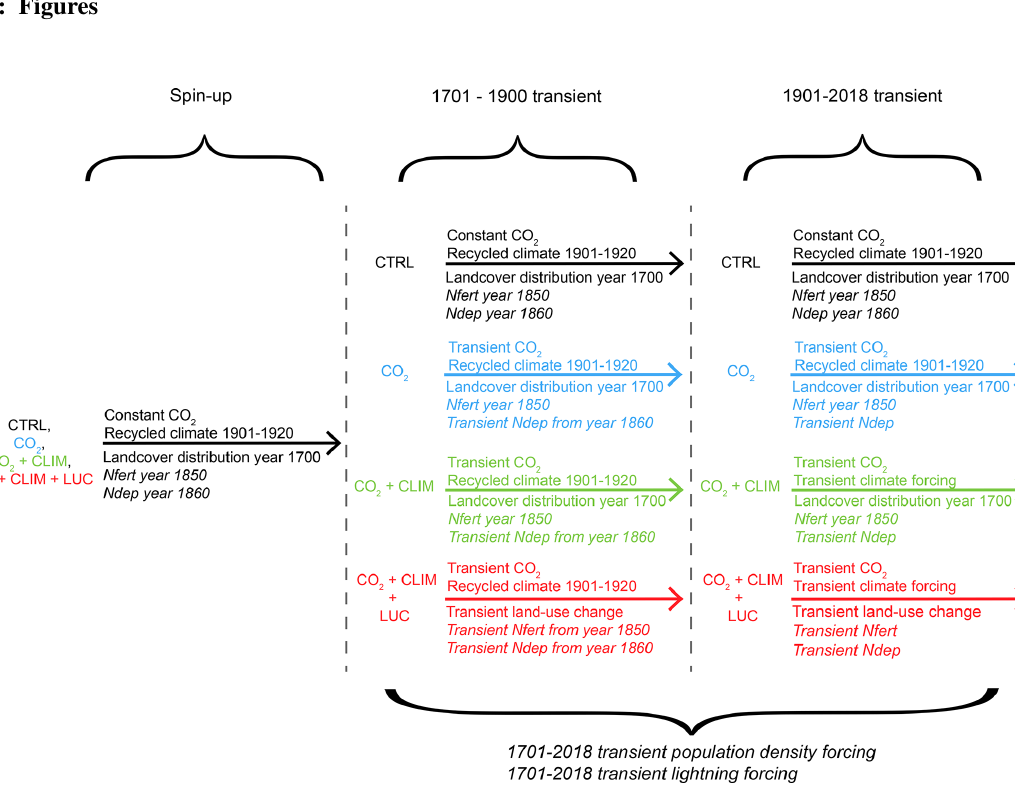
Figure C1. Simulations conducted by the TRENDY models (Friedlingstein et al., 2019). Italic forcing datasets are not used by all